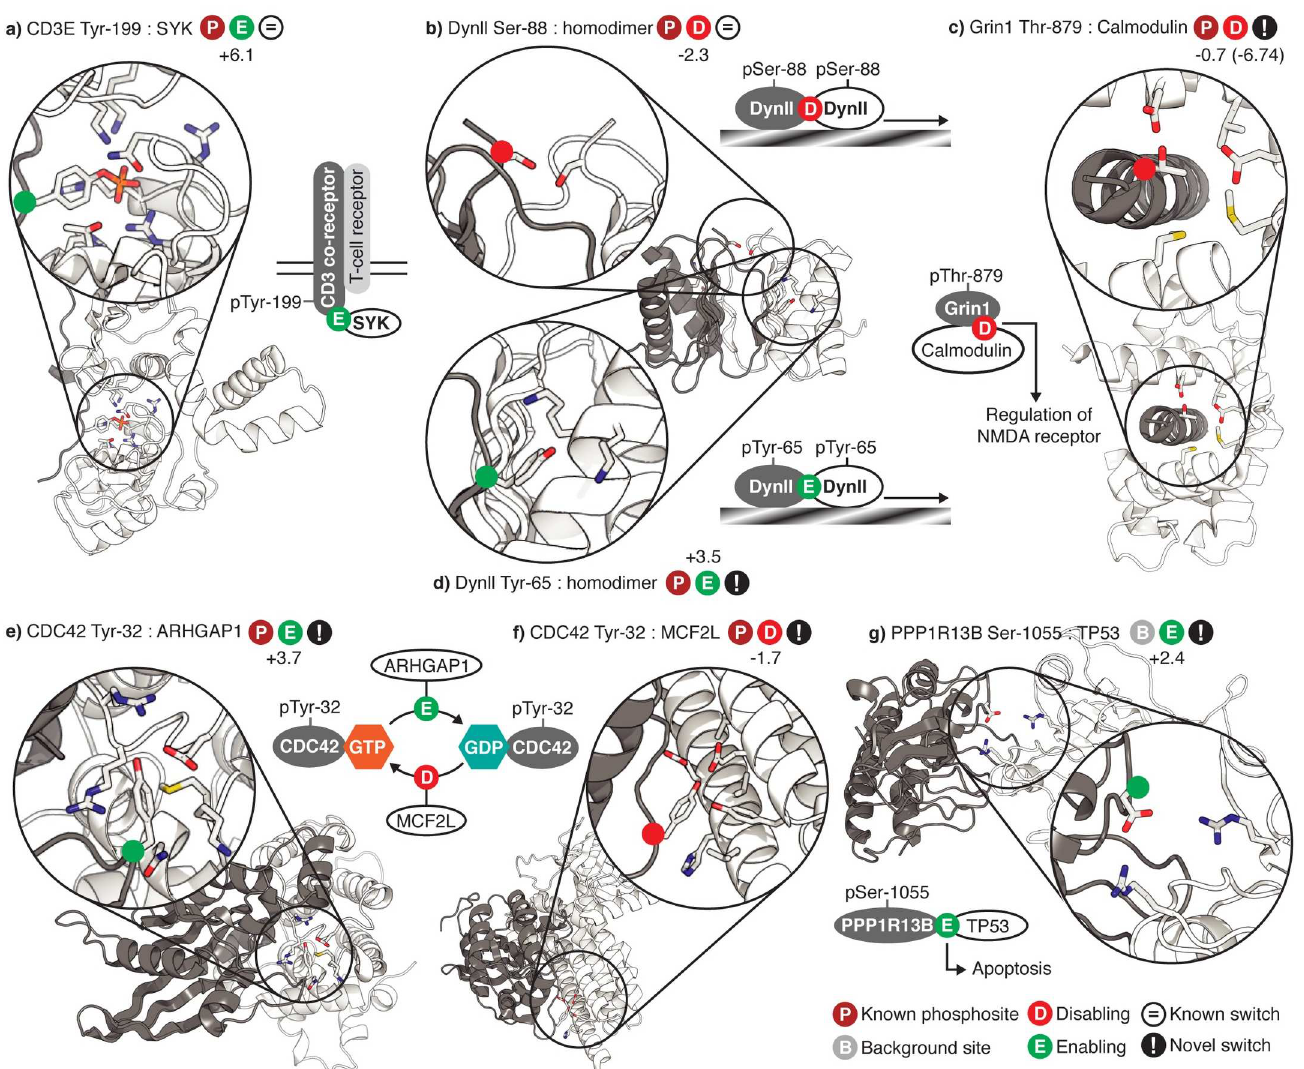
Fig 2. Gallery of phosphosites known or predicted to enable or disable protein interactions. Phosphorylated proteins are shown in grey and the proteinswith which they interact are shown in white. The sidechains of phosphosites and the residues with which they interact are shown as sticks colouredby atom type. Phosphosites are indicatedby coloured dots on C-alphaatoms. S switch scores are shown besidesenablingor disablingsymbols. a) Phosphorylation of Tyr-199 of an immunoreceptor Tyrosine-based activationmotif of the CD3 T-cell co-receptorenablesthe interactionwith